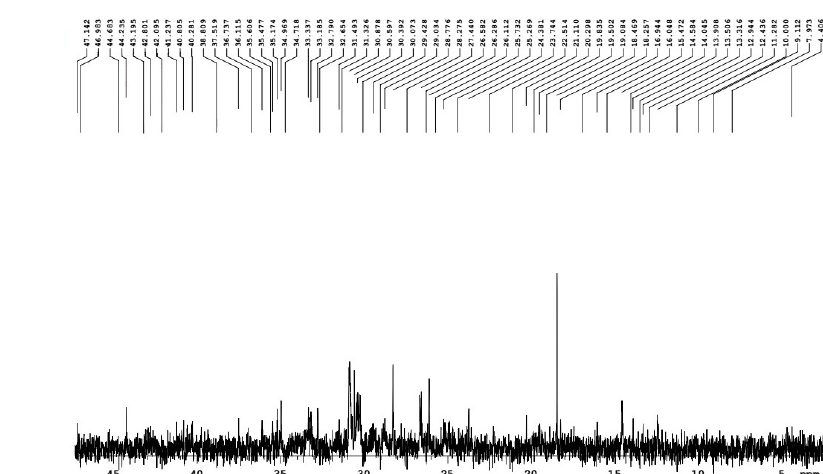
Figure 7. 13 C–NMR total distribution of S. holocarpa wood; ( a – d ) show enlarged views.